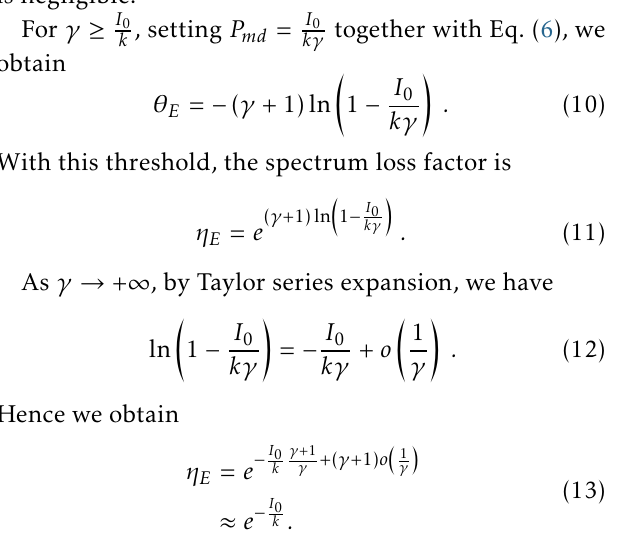
. Figure 3. The efficiency-oriented scheme for NCoS. k = N 0 . Along the direction of the arrow, I